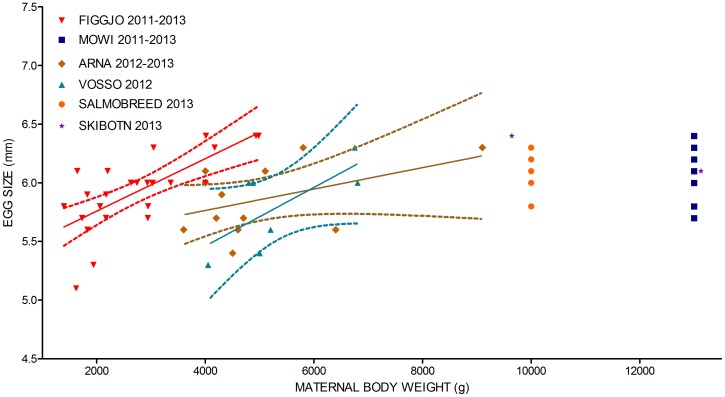
Egg size in relation to maternal body size.The effect of maternal body size upon mean egg sizes in salmon of farmed and wild origin, illustrated by the regression plot between mean egg sizes (mm in diameter) and maternal body weight (grams). Dotted lines illustrate the 95% confidence interval. For model selection of the linear model investigating the relationship between maternal log-weight and egg diameter, see File S1.